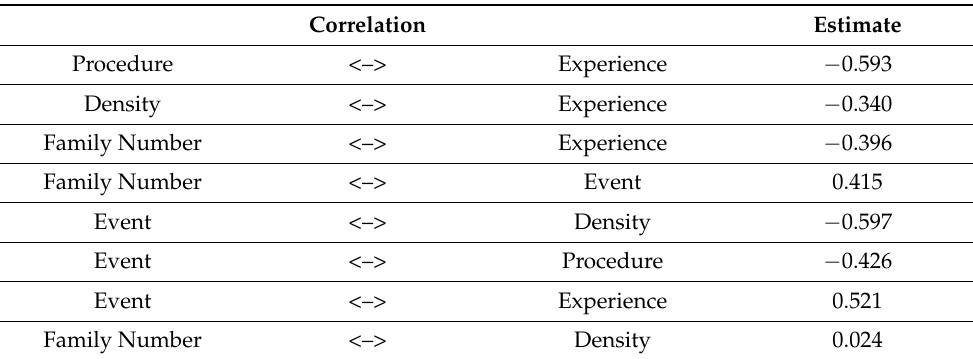
Table 4. Correlation estimates between exogenous variables.